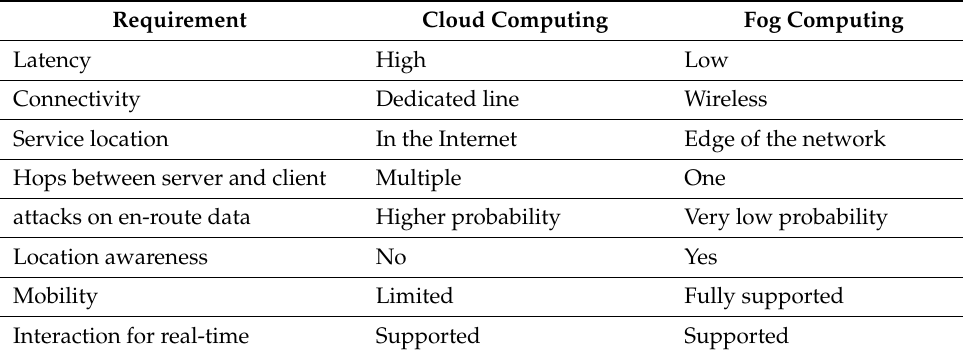
Table 1. Requirements for cloud and